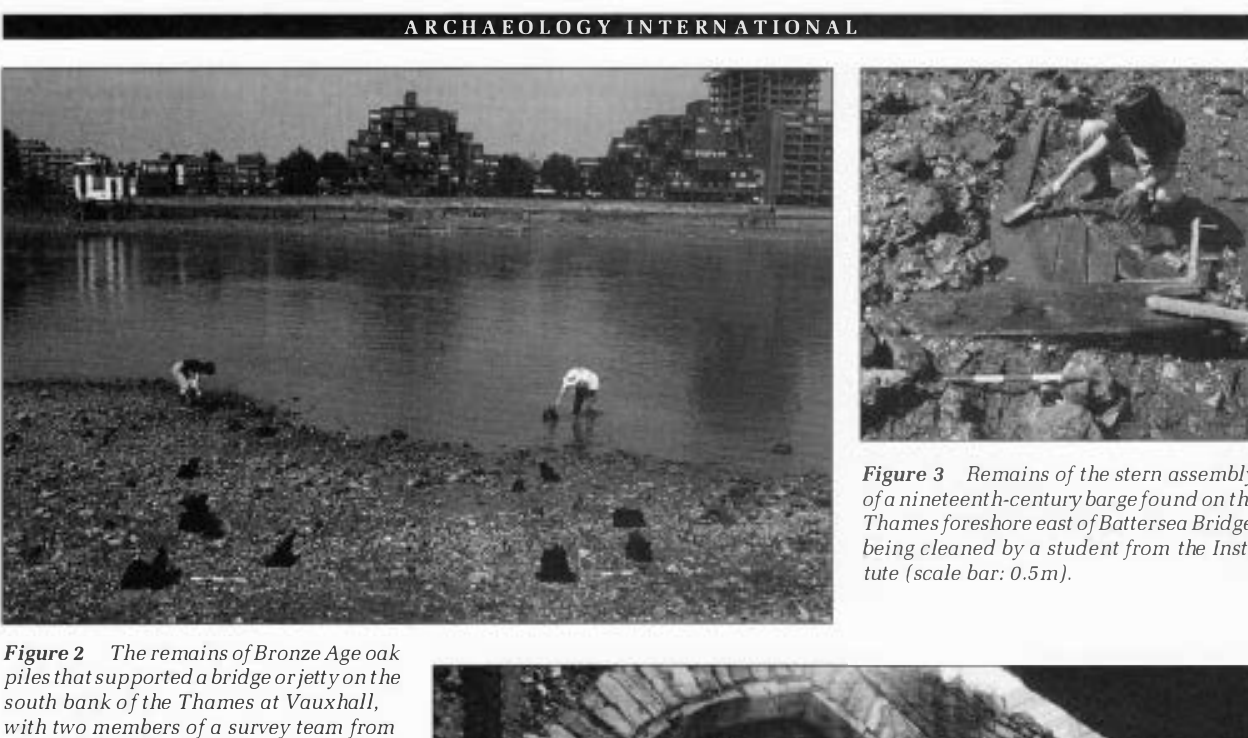
Figure 2 The remains of Bronze Age oak piles that supported a bridge or jetty on the south bank of the Thames at Vauxhall, with two members of a survey team from the Institute of Archaeology, 1998 (scale bars: 0.5m).